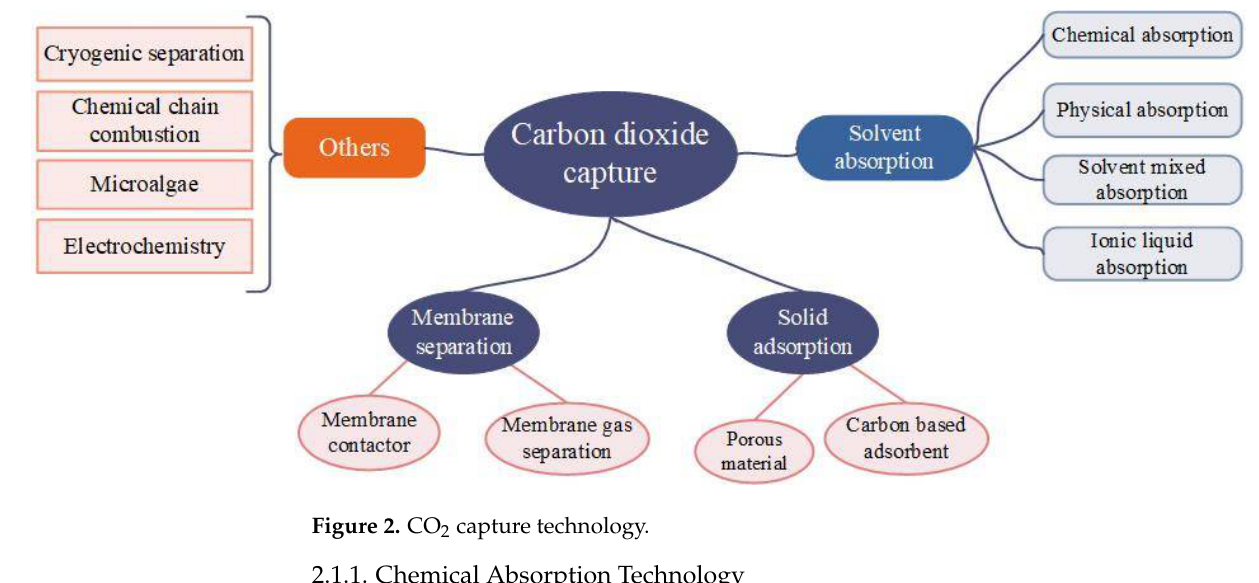
2 capture technology.